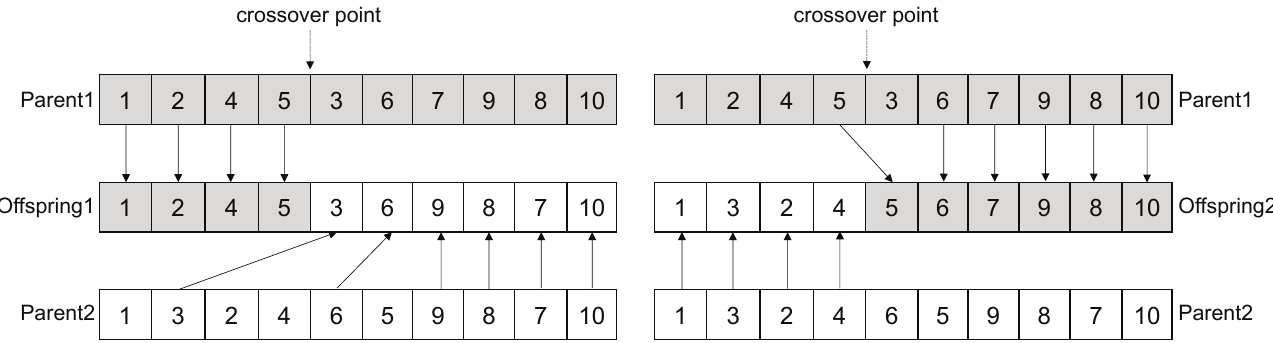
Figure 5. Crossover